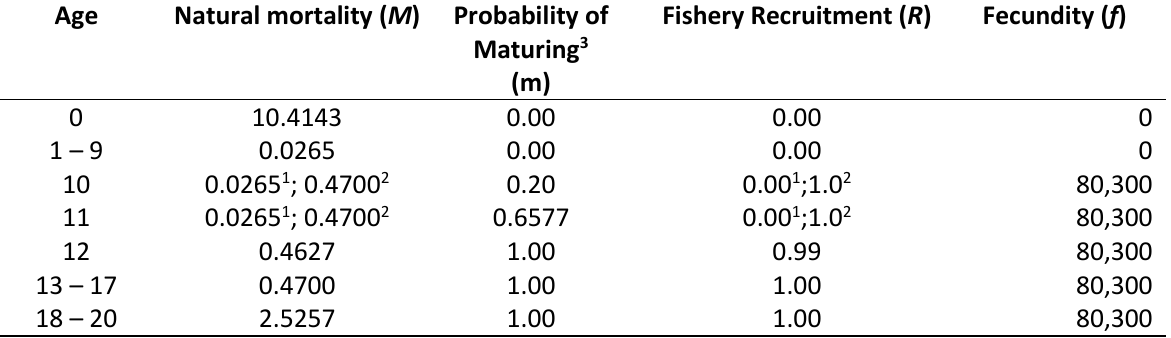
Table 41. Horseshoe crab life history parameters used in the operating